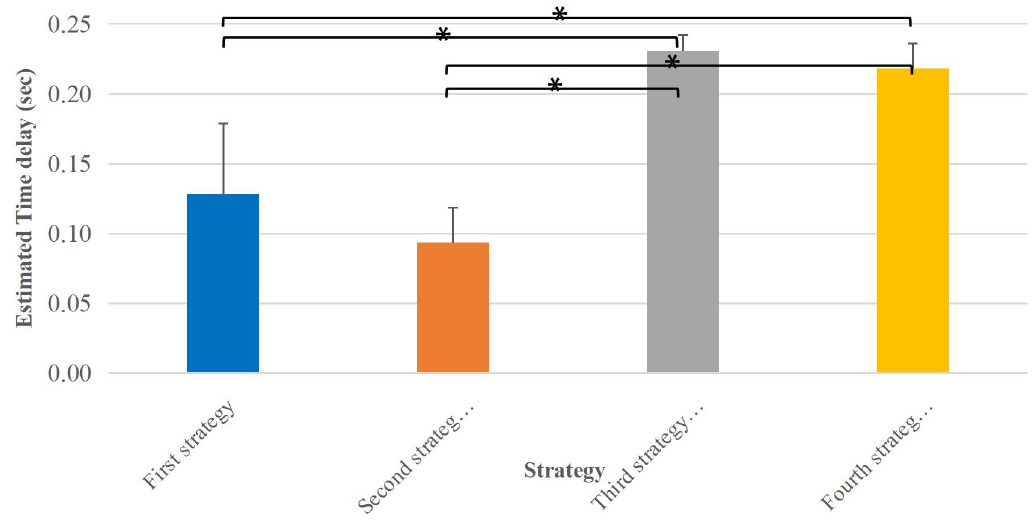
Figure 7. Mean value of all estimated muscle onsets for each strategy. The * stands for significative difference.